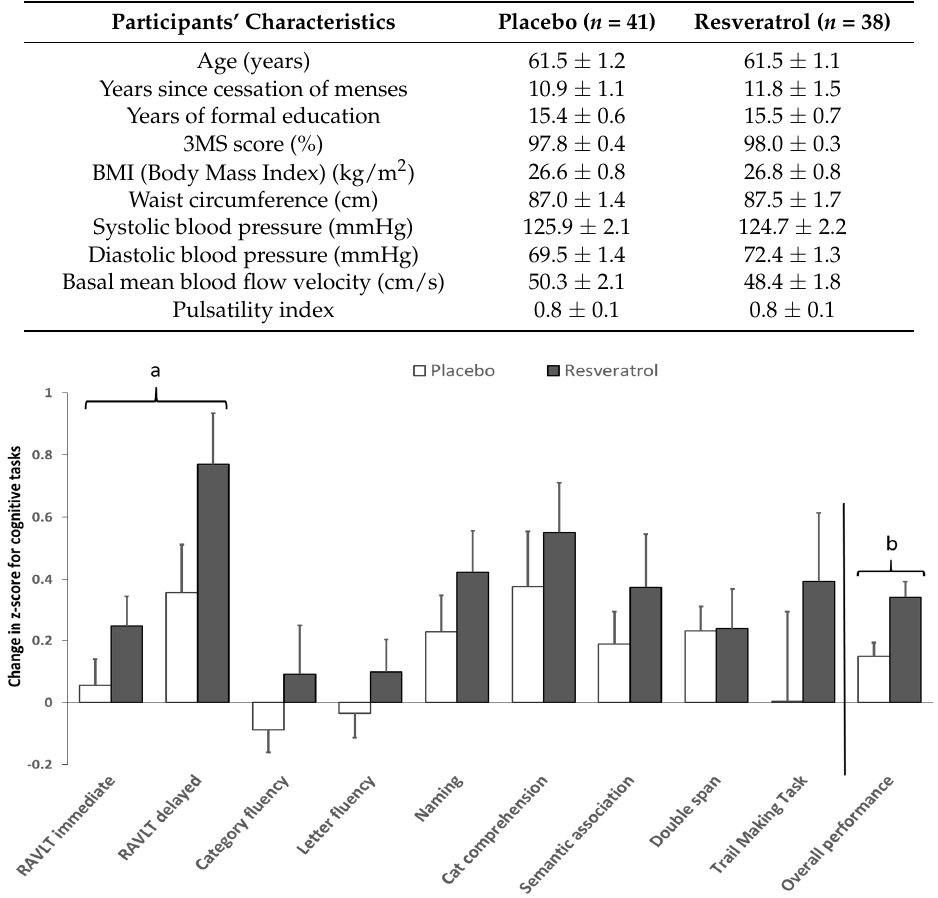
Figure 2. Effects of resveratrol on individual cognitive tests and overcall cognitive performance. Pre